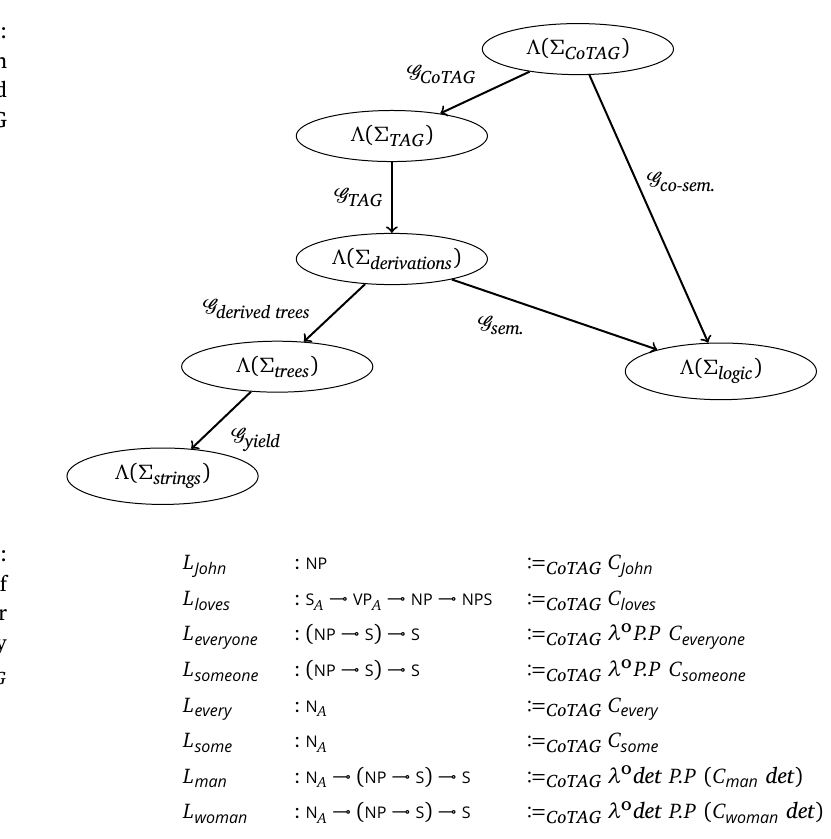
ACG composition for TAG and